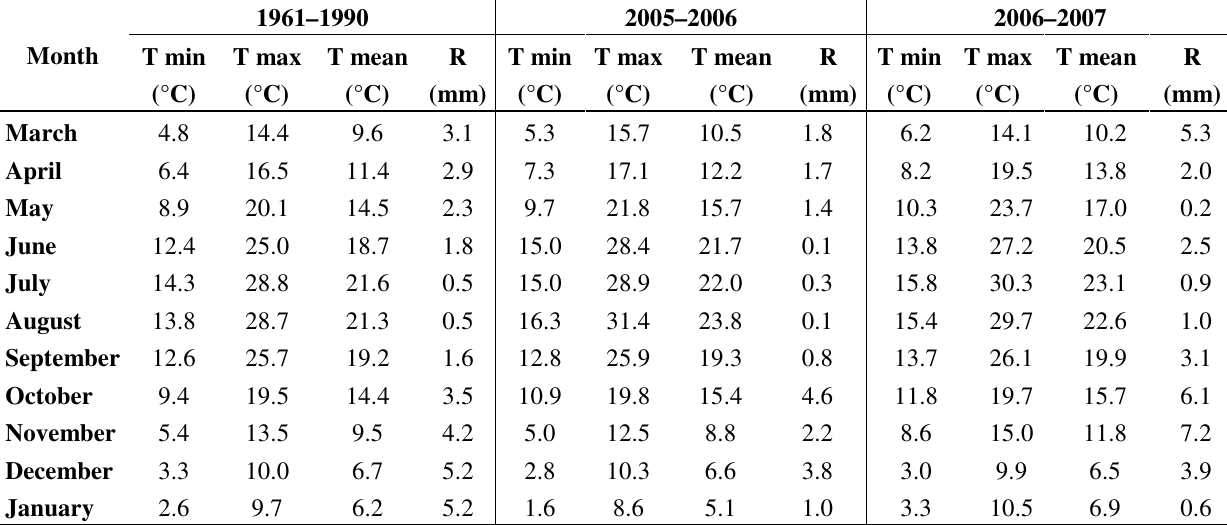
Table 3. Evolution of minimum average temperature (T ), maximum average min temperature (T ), mean average temperature (T ) and average rainfall (mm) in Vila max mean Real region (Northern Portugal), during the entire cycle of Brassica production. Comparison with the average levels in the last 30